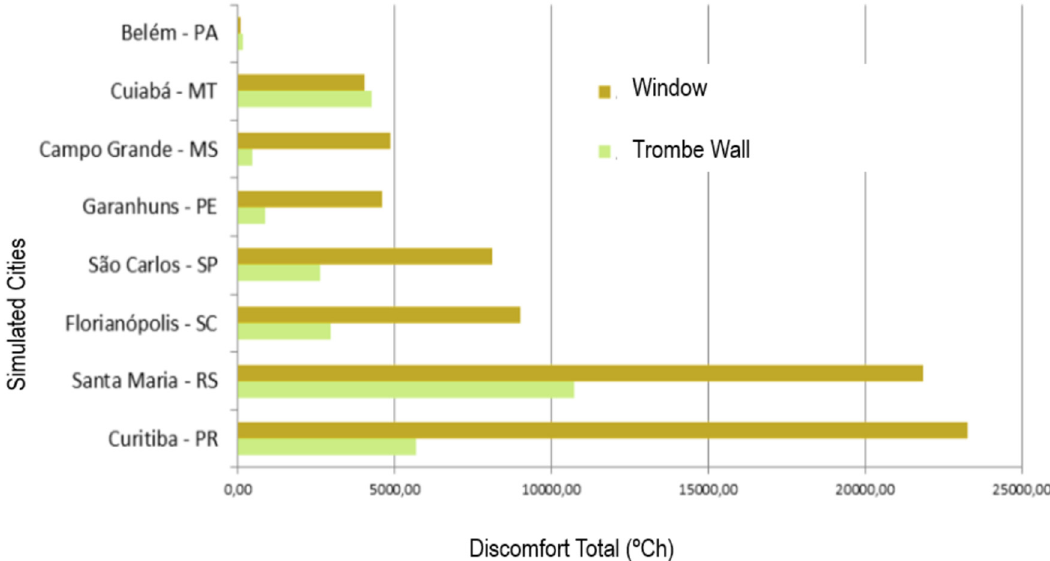
Fig. 9. Comparison between total thermal discomfort for the environment with windows and the best models with Trombe walls in the simulated